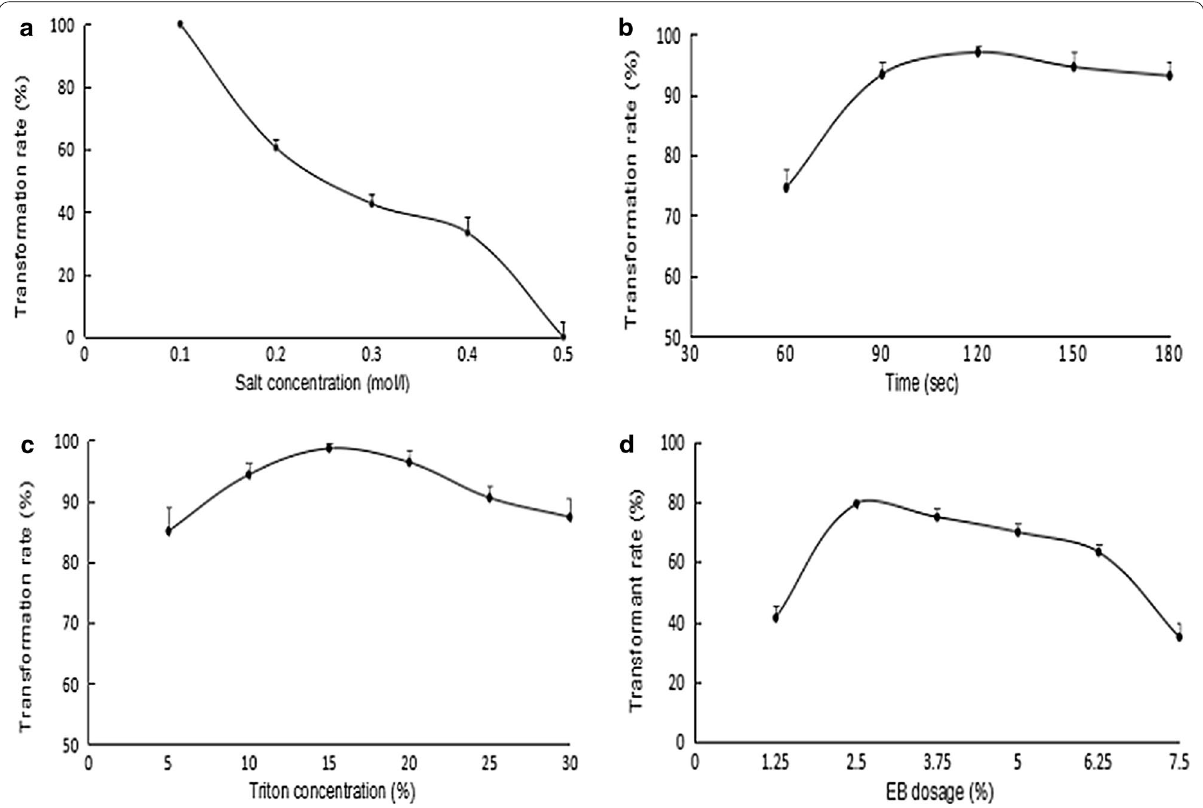
Fig. 3 a – d Denoted the effects of salt gradient, time, concentration of Triton X-100 and EB on the number of transformants, respectively. a The number of transformants increased significantly along with the decrease of salt concentration. When the salt concentration was less than 0.1 M, the number of transformants decreased significantly with the highest value. b The number of transformants increased noticeably with the extension of transformation time. Following the further extension of time, the number of transformants did not increase correspondingly. c The increasing of transformants was associated with the Triton X-100 concentration in a dose-dependent manner. When concentration of Triton X-100 was over than 3.75%, the number of transformants was significantly decreased because of the strong dissolution. d The maximum number of transformants can be achieved with the 10% EB concentration, and decreased significantly at the other concentrations